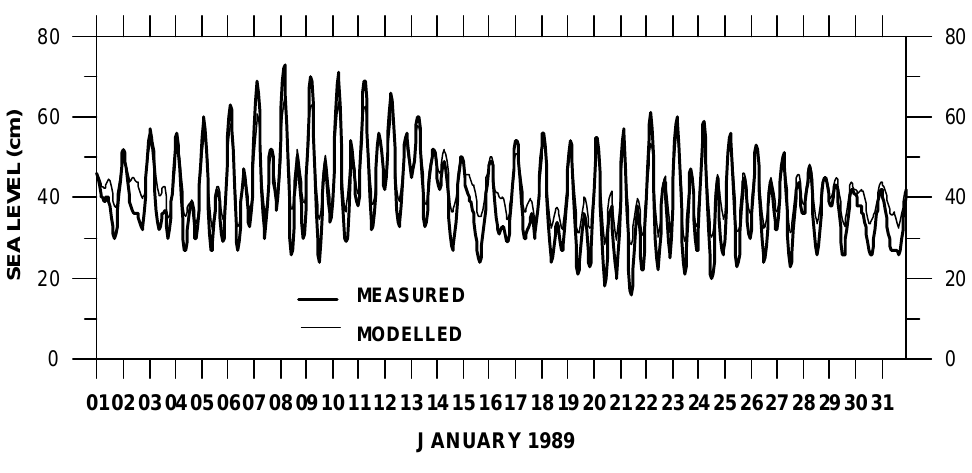
Fig. 10. Comparison between measured and modelled sea levels at Ubli in January